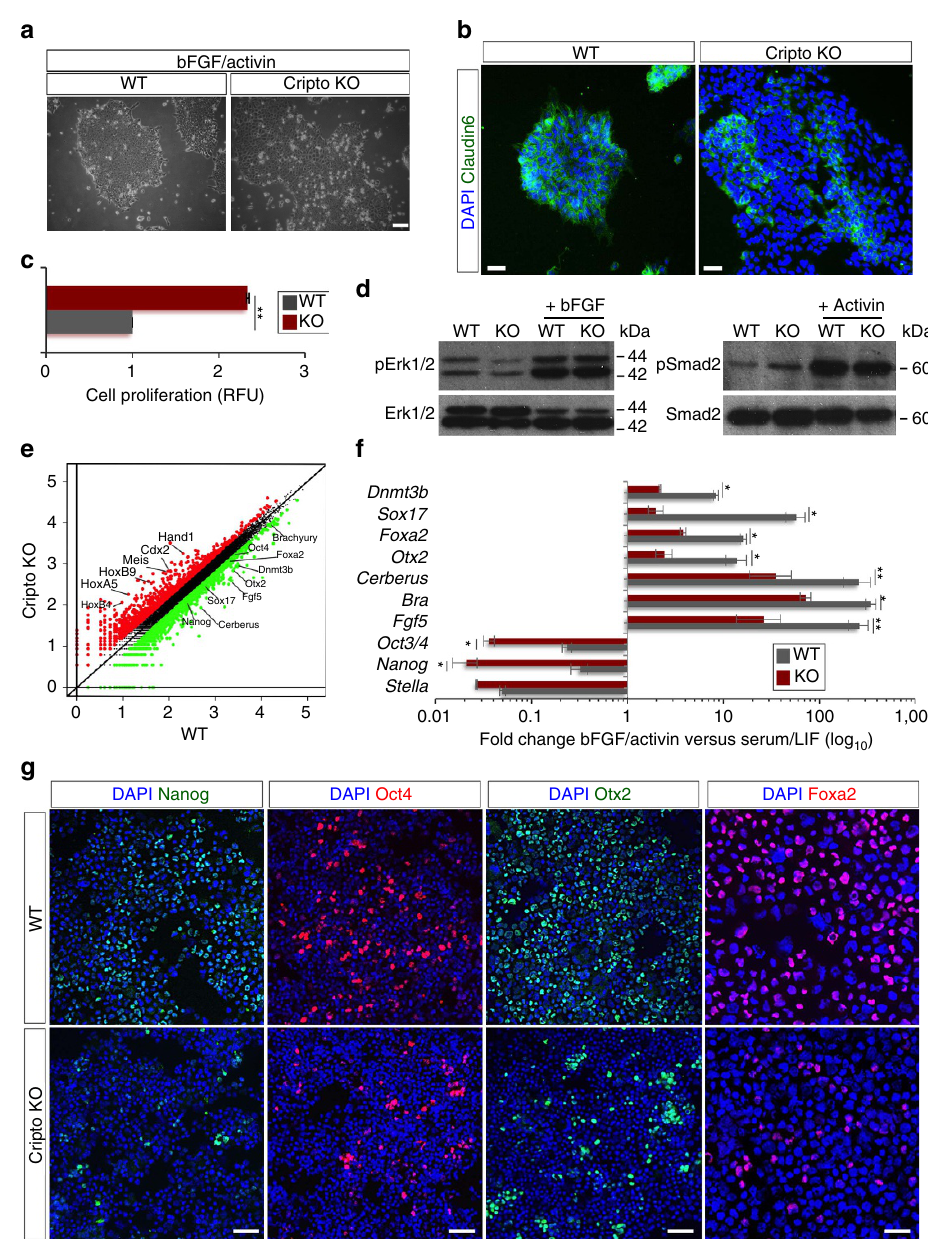
Figure 3 | Cripto genetic ablation prevents ESC - EpiSC transition. ( a ) Representative photomicrographs of FGF/Activin (F/A) WT and Cripto KO cell colonies (scale bar, 100 m m). ( b ) Immunofluorescence of Claudin6 in F/A WTand Cripto KO cell colonies (scale bar, 75 m m). ( c ) Proliferation of F/A WT and Cripto KO cells measured by the CyQuant assay and expressed as relative fluorescence units (RFU). Data are mean ± s.e.m. ( n ¼ 3; ** P o 0.005). ( d ) Western blot analysis of WTand Cripto KO ESCs’ response to bFGF and Activin, using pErk1/2, Erk1/2, pSmad2 and Smad2 antibodies. ( e ) Scatter plot of RNA-seq data shows differentially expressed genes in F/A Cripto KO versus WTcells. The black circles delineate the boundaries of o 2-fold difference in gene expression levels. Genes showing a higher or lower expression level (log 10 FC 4 0.2) in Cripto KO versus WTare indicated as red and green circles, respectively. ( f ) Effect of F/A on the expression of selected markers in WTand Cripto KO ESCs. Data are expressed as fold change of EpiSCs (F/A) versus ESCs (serum/LIF) after normalization to Gapdh and are mean ± s.e.m. ( n ¼ 3; * P o 0.01 and ** P o 0.005). ( g ) Representative pictures of Nanog, Oct4, Otx2 (scale bar, 100 m m) and Foxa2 (scale bar, 75 m m) immunostaining in cytospinned F/A WT and Cripto KO cells. Nuclei were stained with 4,6-diamidino-2-phenylindole reprogramming was affected in Cripto KO ESC - EpiSC asked whether inhibition of oxidative phosphorylation by the transition, we measured lactate production as an indicator of mitochondrial ATP synthase inhibitor oligomycin 32 could rescue the glycolytic activity in F/A WT and Cripto KO cells, from two F/A-induced Cripto KO EpiSCs (Fig. 4e–i). Interestingly, F/A- independent Cripto KO ESC clones (KO.1 and KO.2), and found treated Cripto KO ESCs generated tightly packed EpiSCs-like that it was significantly reduced in Cripto KO compared with colonies in the presence of oligomycin, with reduced proliferation Control (Fig. 4d). To evaluate whether this failure to undergo rates and large areas of Claudin6-positive cells (Fig. 4e–g). metabolic reprogramming leads to the mutant phenotype, we Furthermore, oligomycin treatment fully rescued lactate